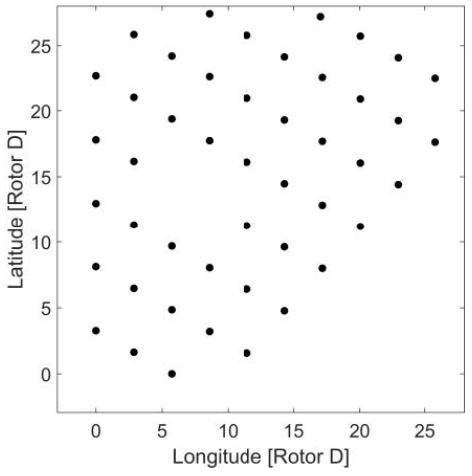
Figure 2. Layout of the Lillgrund wind farm.